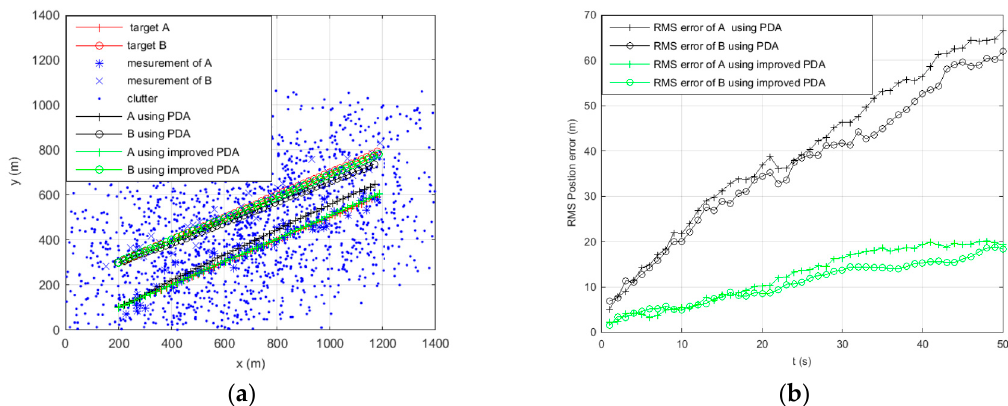
Figure 3. Tracking two parallel targets using PDA and improved PDA when clutter λ = 5. ( a ) Tracking of the target position; and ( b ) RMS position error of the target.